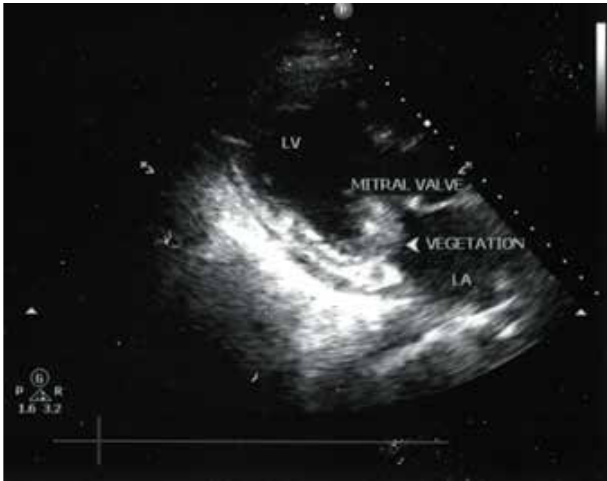
Fig. 1. Echocardiogram showing the size and position of the vegetation.